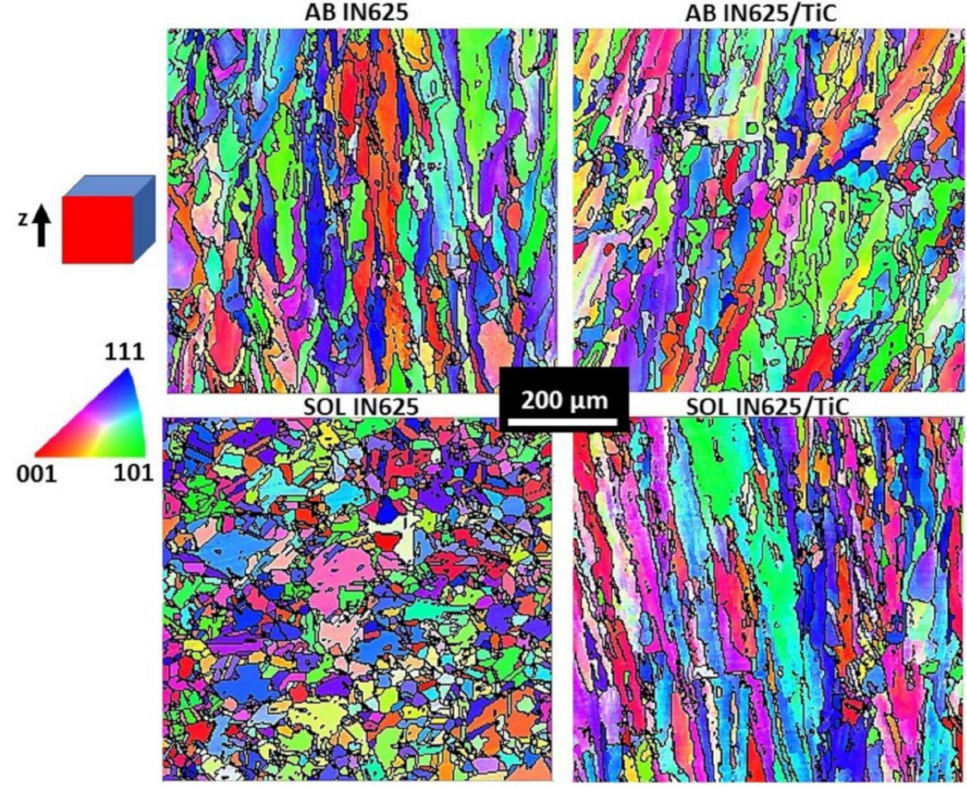
Figure 2. EBSD maps of the AB and SOL IN625 and IN625/TiC conditions along the building direction (z-axis). The corresponding inverse pole figure is also included. HAGBs ( θ > 10 ◦ ) are pointed out by black